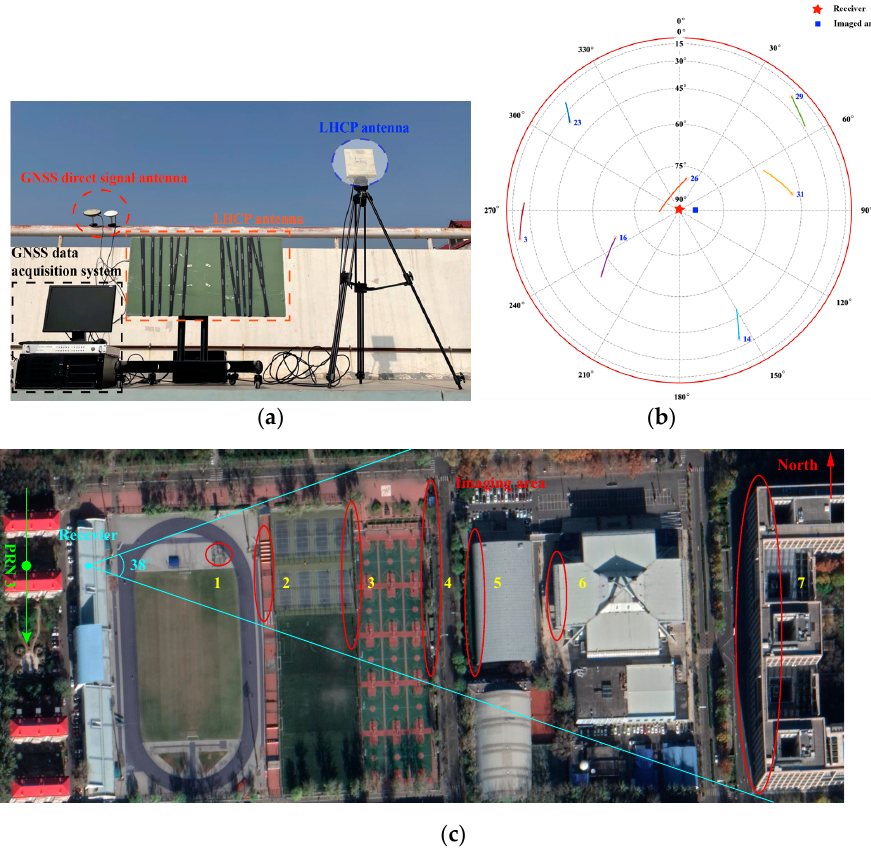
Figure 8. Experiment specific configuration. ( a ) Experimental equipment hardware, ( b ) geometric configuration at the time of collection, ( c ) optical image of experimental area (Google Earth map). Target No. 1 is a circular metal fence, Target No. 2~4 is metal fence, Target No. 5 is the swimming pool, Target No. 6 is the gymnasium, Target No. 7 is the E, F, G blocks of the new main building. Table 5. Parameters used in the experiment.